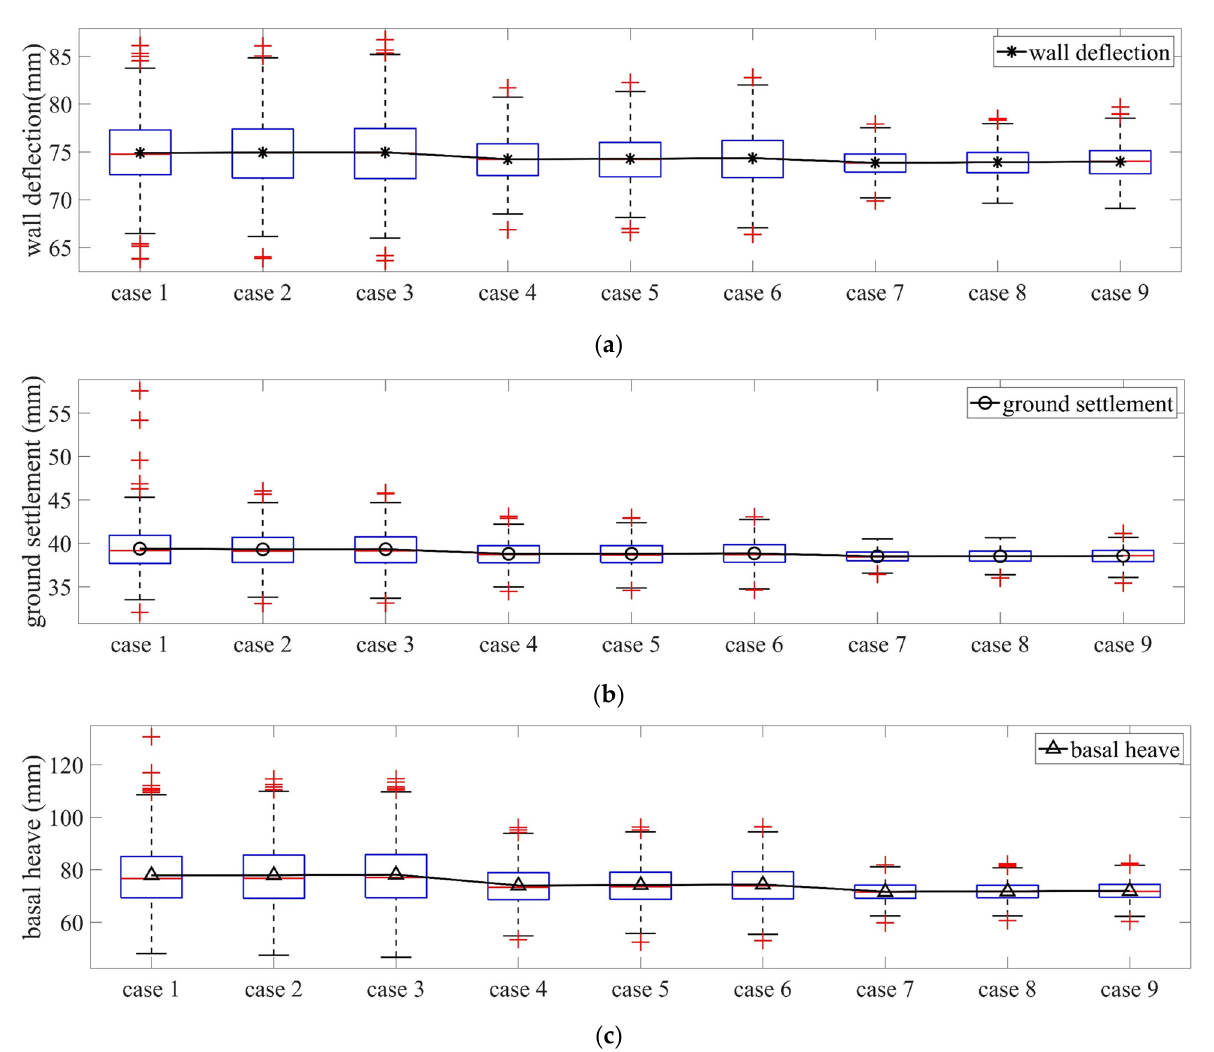
Figure 7. The effect of COVc u and COV φ on excavation responses: ( a ) Boxplot of wall deflection; ( b ) Boxplot of ground settlement; ( c ) Boxplot of basal heave.